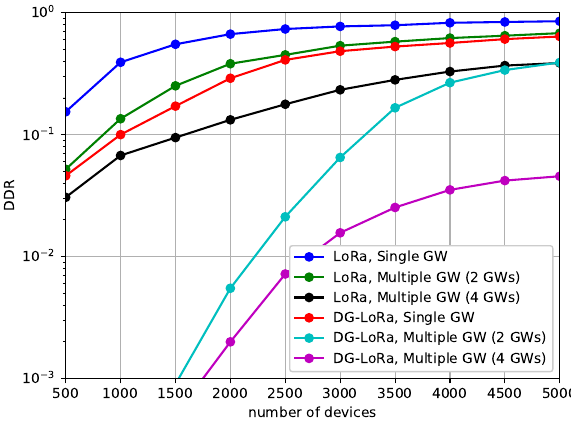
Figure 8. Data drop rate according to the number of